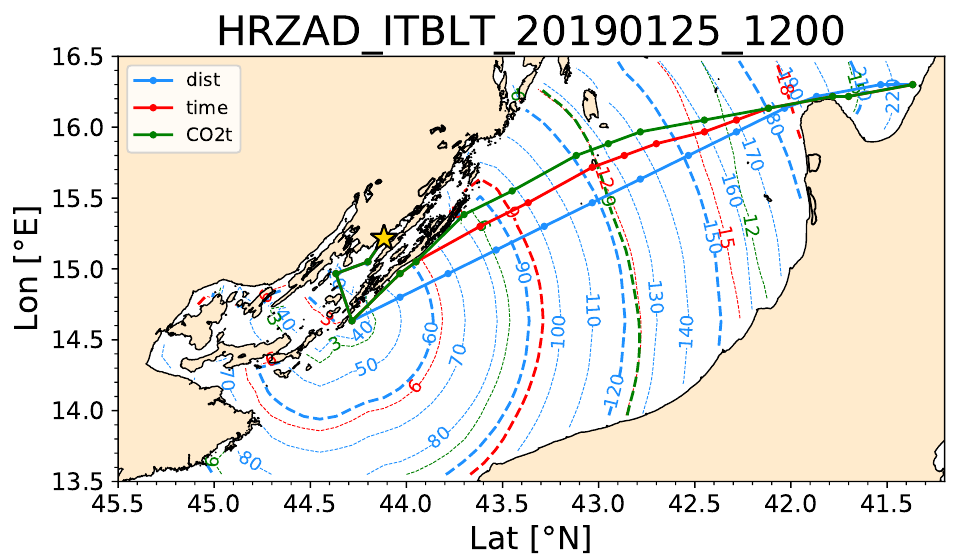
Figure 2. Exemplary results of route optimization. Least-distance, least-time, and least-CO 2 routes from Zadar (Croatia) to Barletta (Italy) are displayed respectively as cyan, red, and green lines with dots at the computed waypoint locations. The isolines corresponding to each route (cf. Table 2) are displayed as dashed or dotted lines (for major or minor divisions, respectively) of the corresponding colour. The labels of the isolines are expressed in units of nautical miles, hours, or tonnes CO 2 , respectively, and engine fractional load was χ =